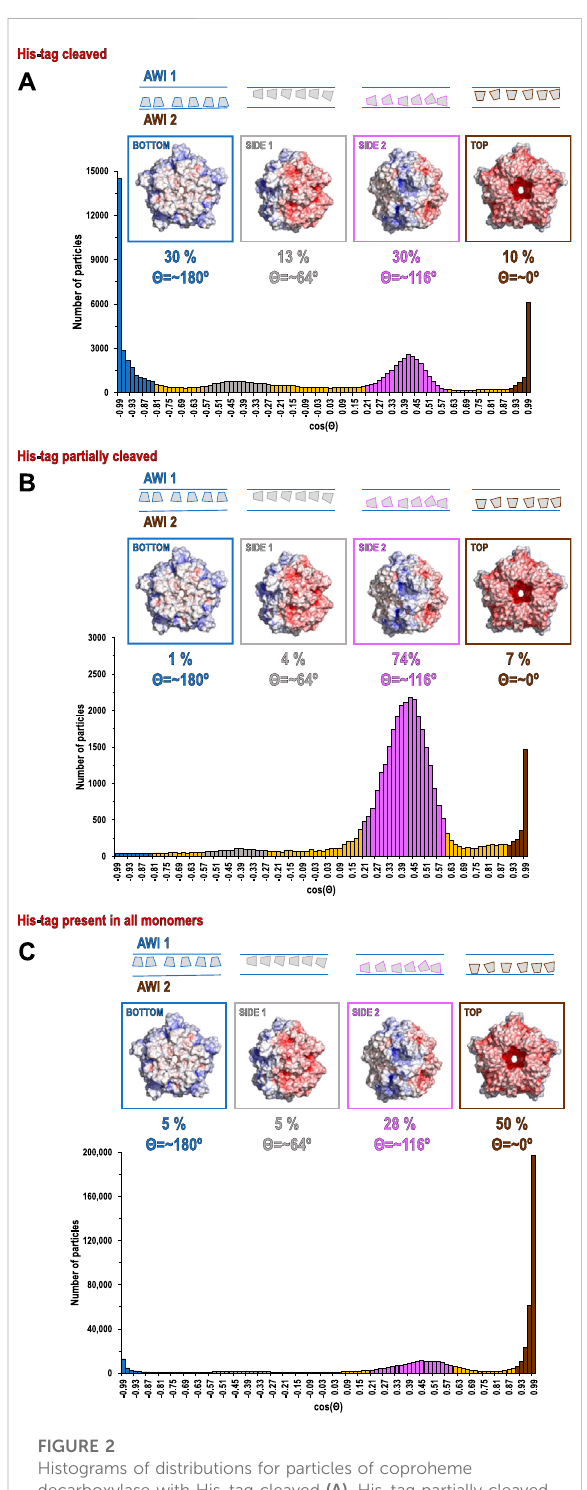
FIGURE 2 Histograms of distributions for particles of coproheme decarboxylase with His-tag cleaved (A) , His-tag partially cleaved (B) , and His-tag uncleaved (C) . The histograms show the number of particles as the function of cosine Θ , where Θ is the angle between the 5-fold axis of the particle and the direction of the beam.Themapoftheelectrostaticpotentialforeachorientationis shown above the speci fi c peaks corresponding to the most frequent